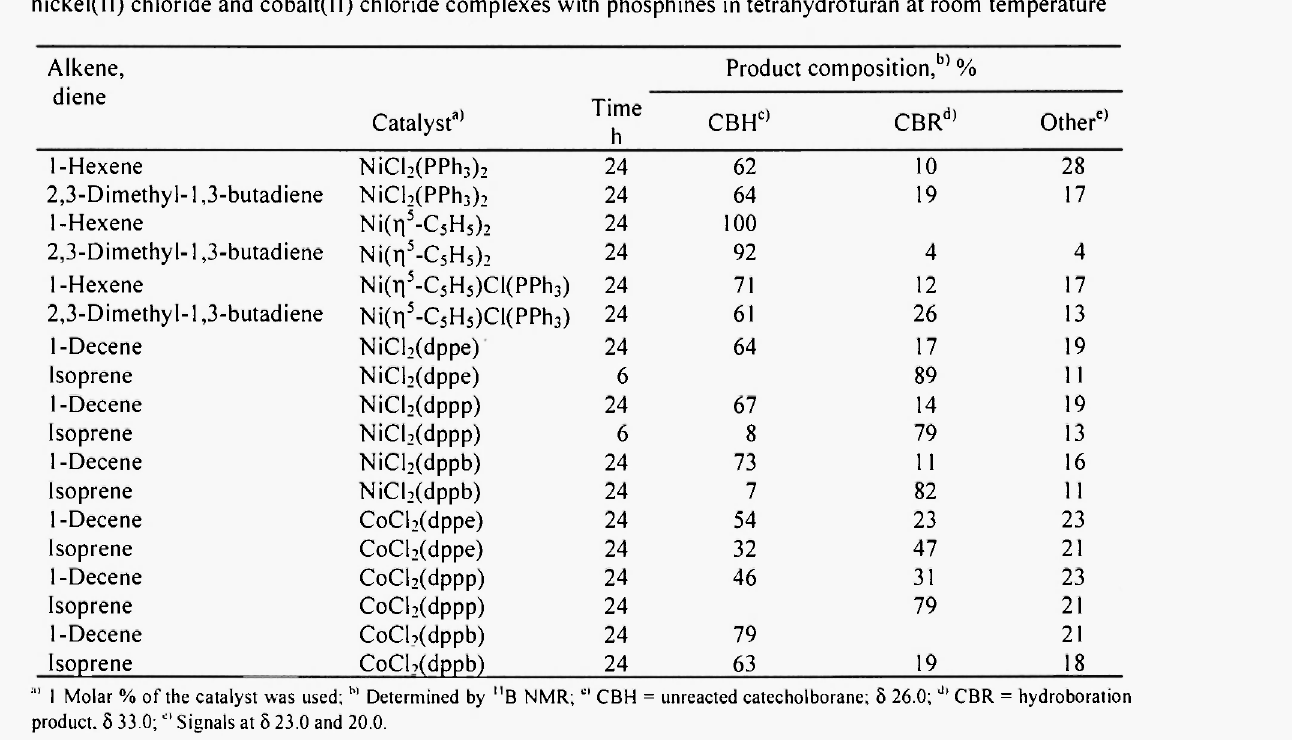
Table 1. Hydroboration of terminal alkenes and conjugated dienes with catecholborane in the presence of nickel(II) chloride and cobalt(II) chloride complexes with phosphines in tetrahydrofuran at room temperature